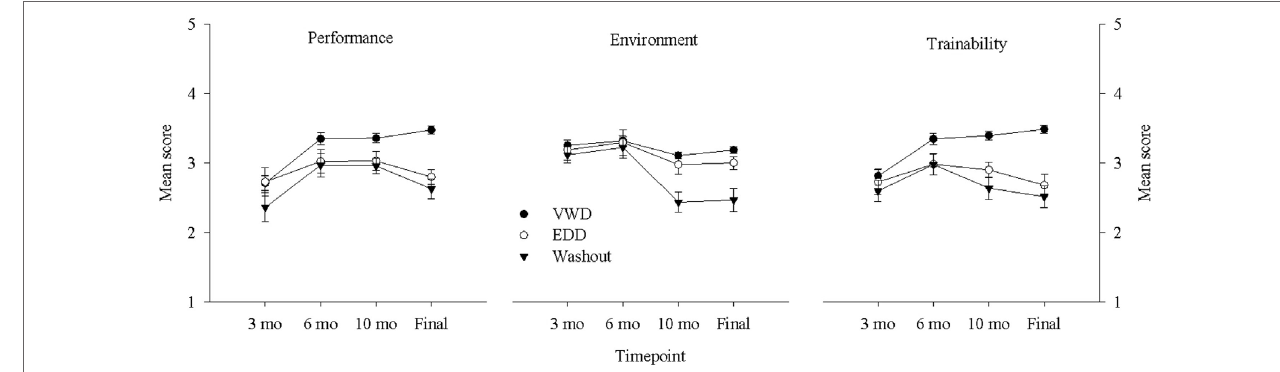
FigUre 2 | Average scores for each group [VW dog (VWD), explosives detection dog (EDD), Washout] in the Performance (left panel), Environmental (middle panel), and Trainability (right panel) domains across each of the evaluation timepoints (3 mo, 6 mo, 10 mo, and Final Evaluation). Error bars represent standard errors of the